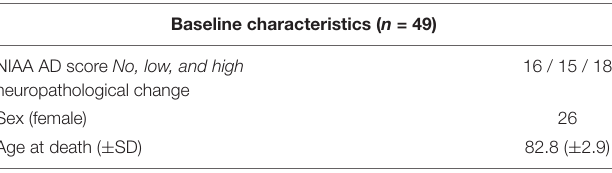
TABLE 1 | Baseline characteristics including the age of death and therefore neuropathological examination, sex distribution as well as NIAA AD score. Baseline characteristics ( n = 49) NIAA AD score No, low, and high neuropathological change